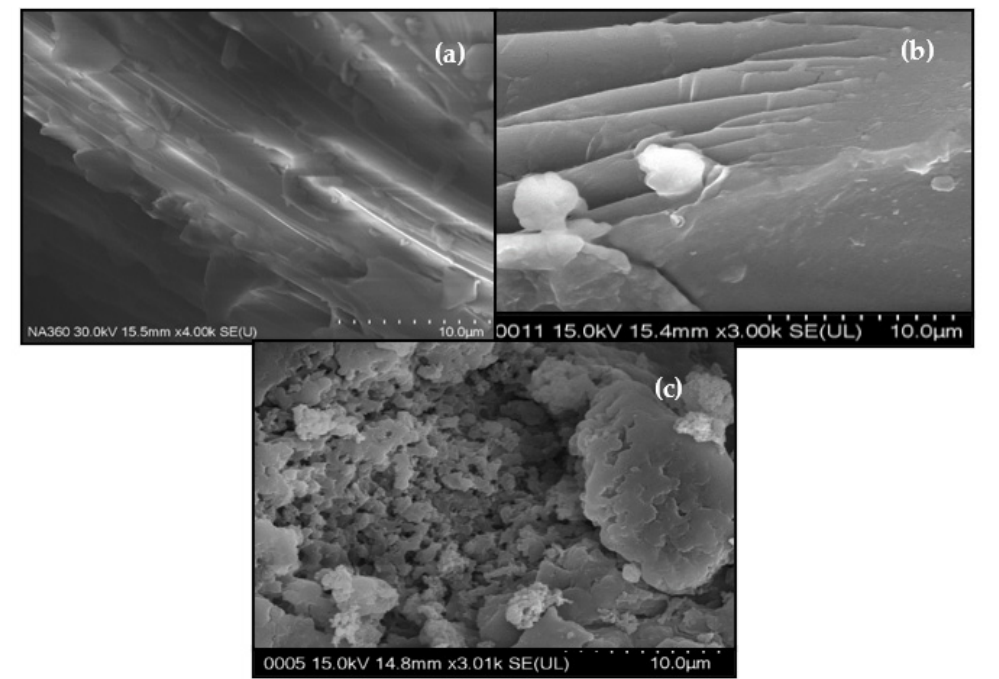
Figure 6. SEM images of ( a ) PBAAA , ( b ) CHIT and ( c ) CHIT-PAAA